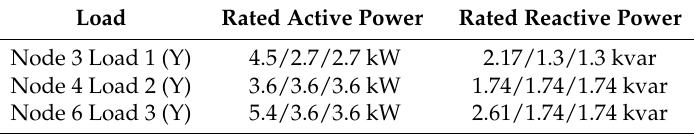
Table 3. Nominal power of the loads and type of connection.